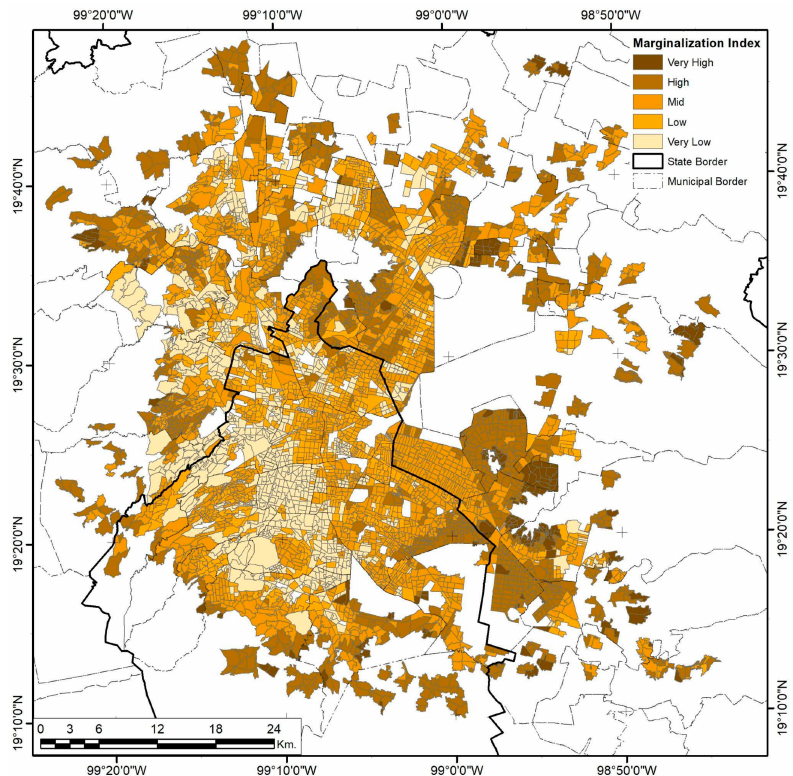
Figure 14. Mexico City Urban Marginalization Index (UMI) by AGEB. Developed by the authors with data from [62].